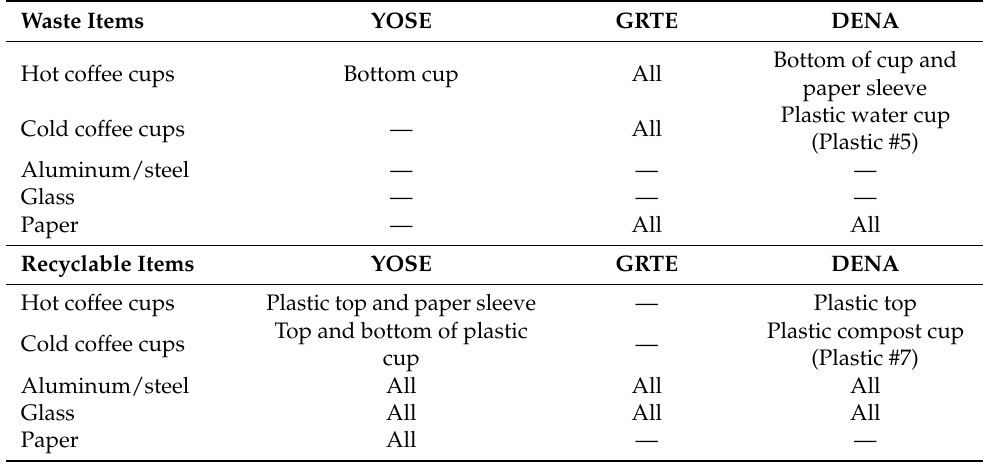
Table 5. Observation Protocols for Proper Disposal of Waste in Campgrounds by Park. Waste Items